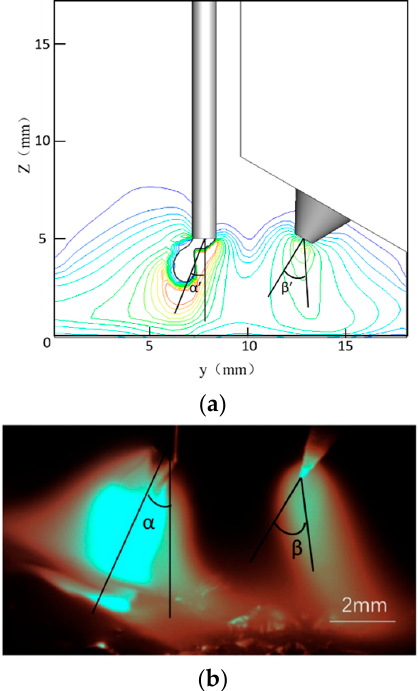
Figure 14. A comparison of MIG and TIG arc deflections: ( a ) arc shape simulation; ( b ) experimental diagram of the arc shape.